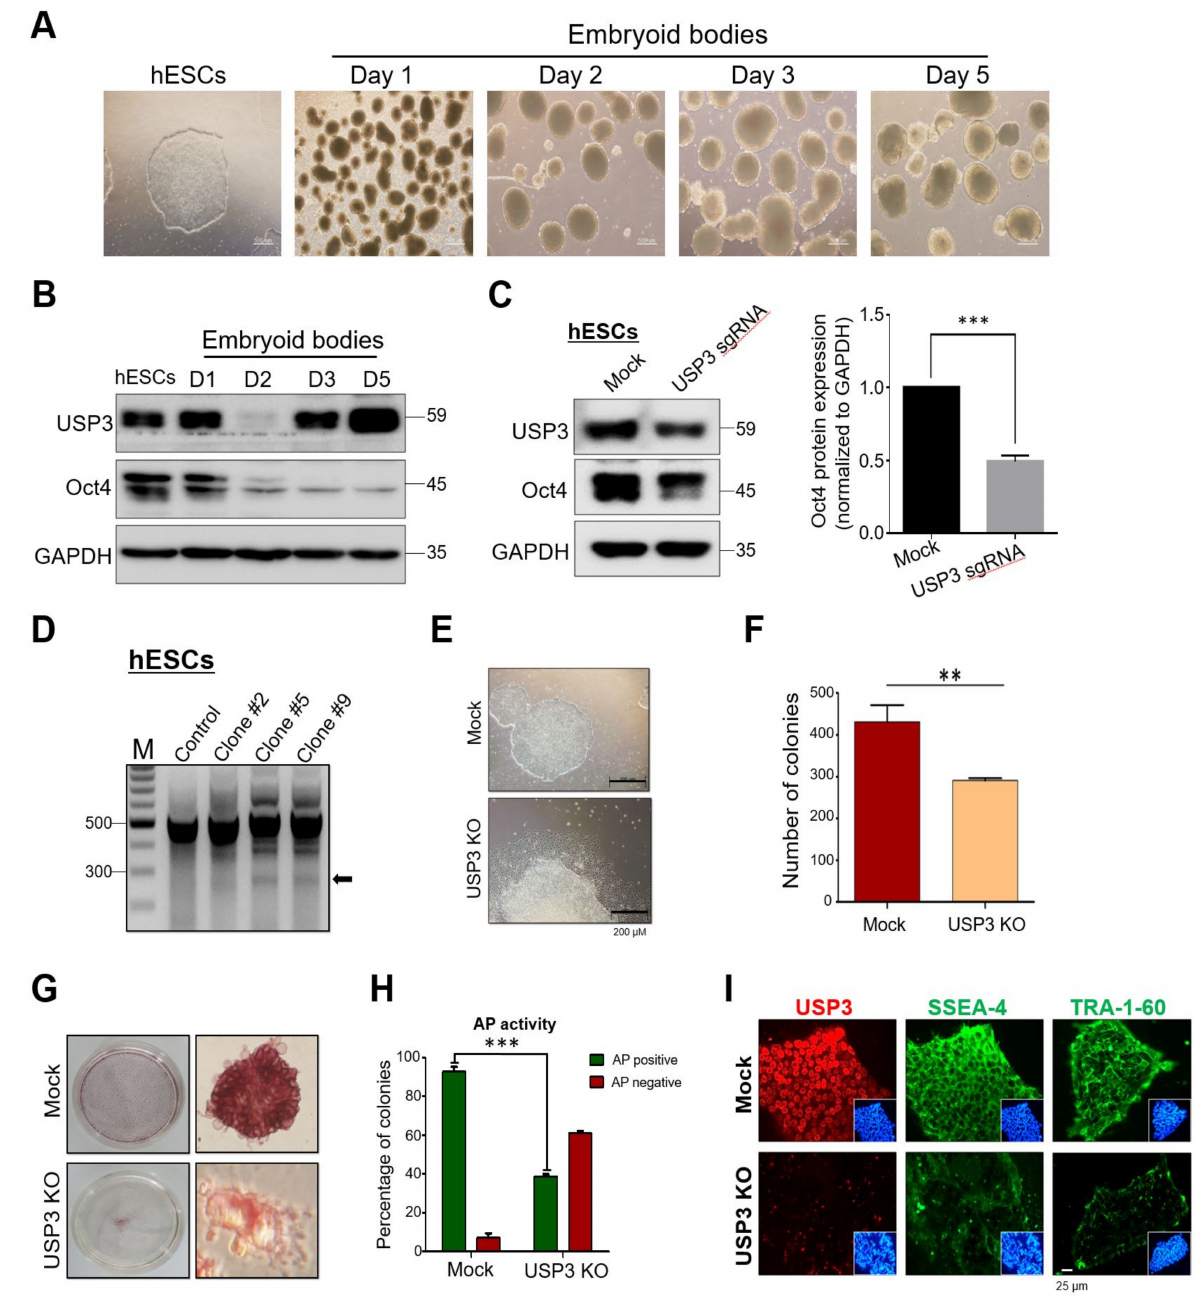
Figure 5. Loss of USP3 affected hESCs morphology and colony numbers. ( A ) hESCs were subjected to embryoid body (EB) differentiation for 5 days by dissociation of hESC clumps using collagenase IV and culturing the aggregates using Essential 6 TM Media. ( B ) Western blot analysis of differentiating EBs (days 1–5) was performed using the indicated antibodies. D1-D5 indicate the number of days of EB culture, and cells were collected at the indicated time points for Western blot analysis ( C ) hESCs were transfected with plasmids encoding USP3 targeting sgRNA and Cas9. The expression of USP3 and Oct4